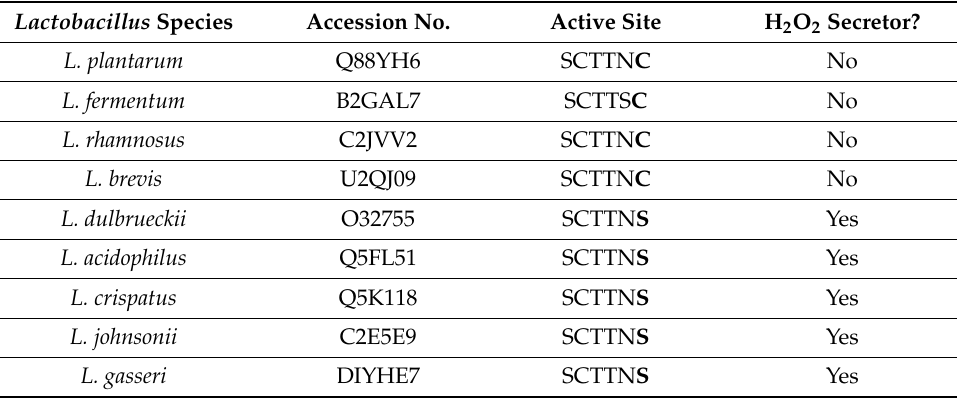
Table 2. Correlation of GAPDH active site primary sequences of five non − H 2 O 2 secretors and